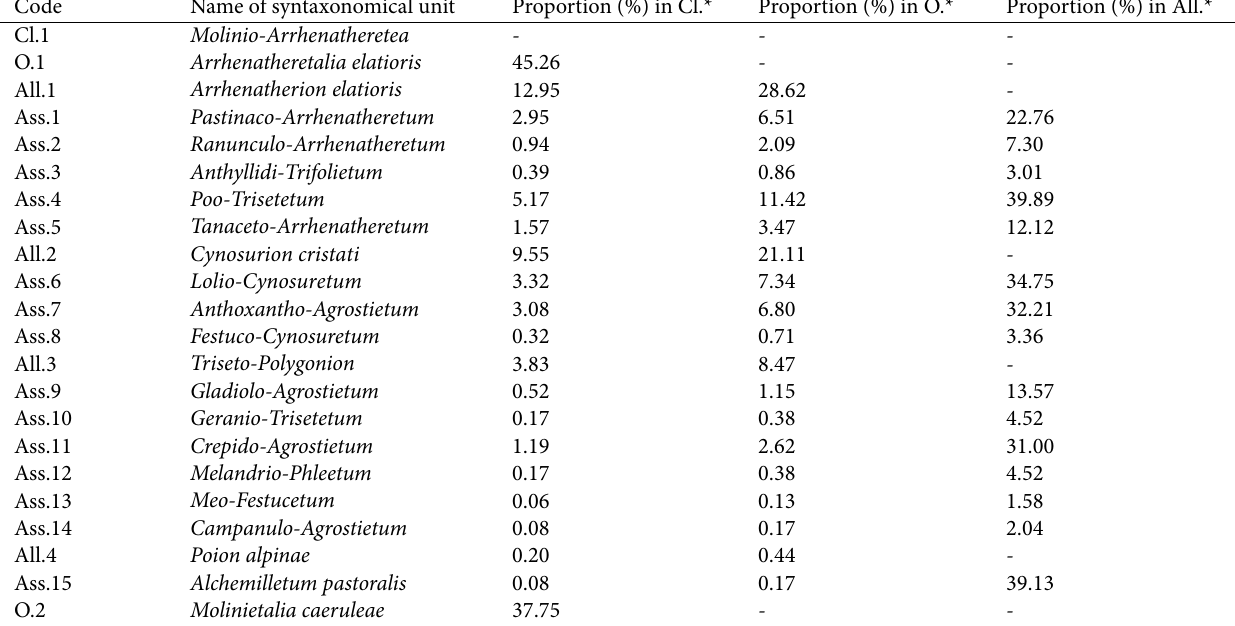
Table 1 The synopsis of vegetation units of the Molinio-Arrhenatheretea class in Poland. Code Name of syntaxonomical unit Proportion (%) in